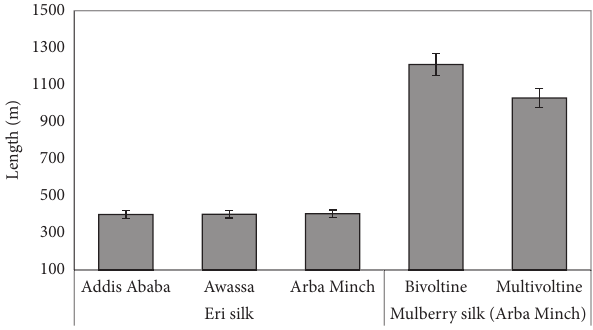
Figure 4: Length of eri and mulberry silk